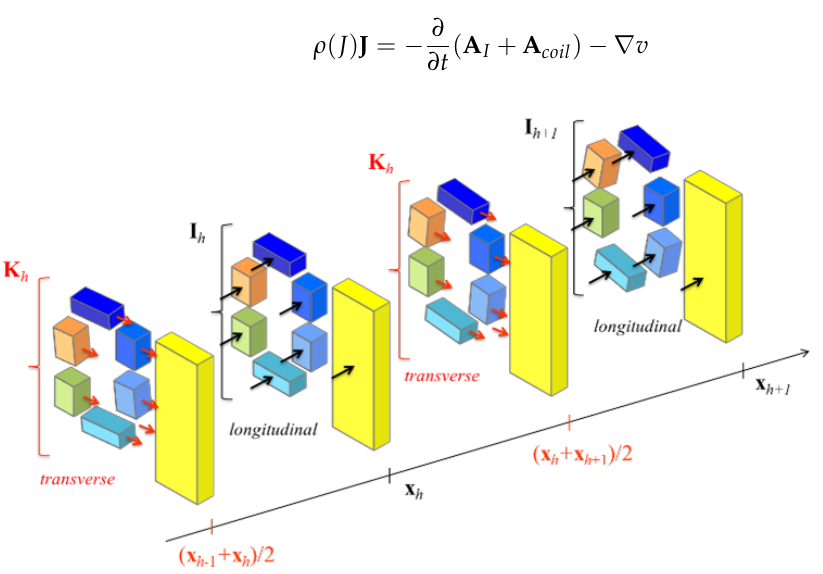
Figure 6. Representation for the interleaved longitudinal and transverse current distribution prob- lems. Red arrows represent the total transverse current exchanged through the overall lateral surface and can leave (if > 0) or enter (if < 0) the element. Black arrows represent the longitudinal currents at terminal sections of the elements and may differ from each other due to the transverse